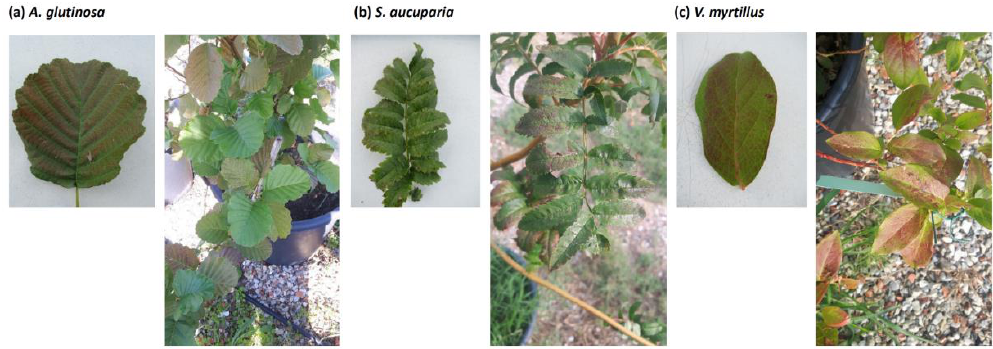
Figure 2. Photographs of symptomatic leaves in Alnus glutinosa , Sorbus aucuparia, and Vaccinium myrtillus in an O 3 FACE experiment in 2018. Dark or reddish stippling on the upper leaf surface was found.